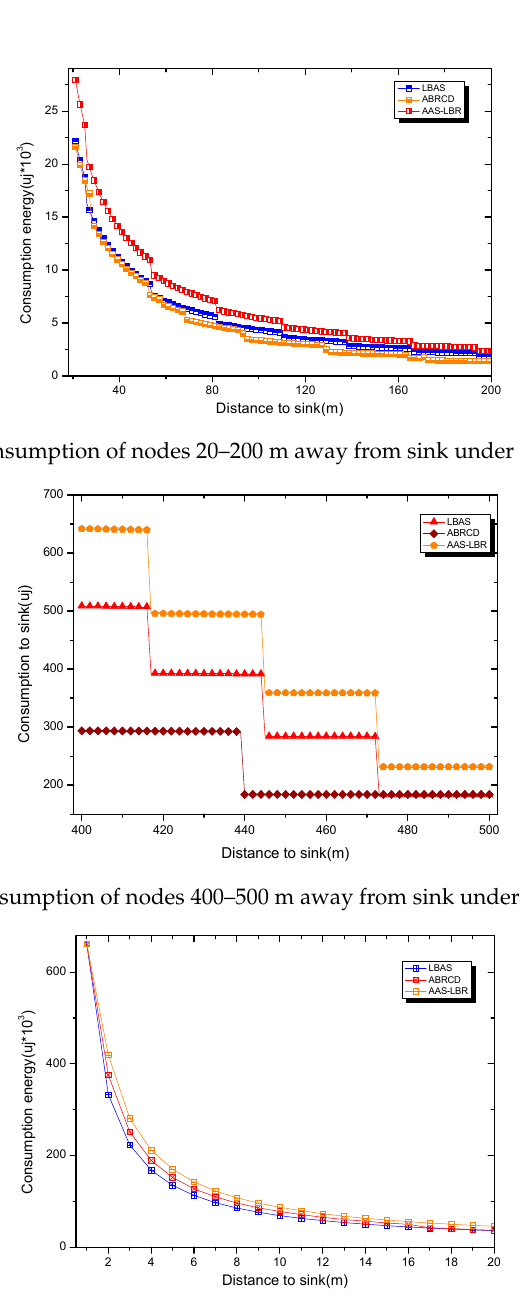
Figure 31. Energy consumption of nodes 1–20 m away from sink under 𝑇 = 100 and r = 28 m .